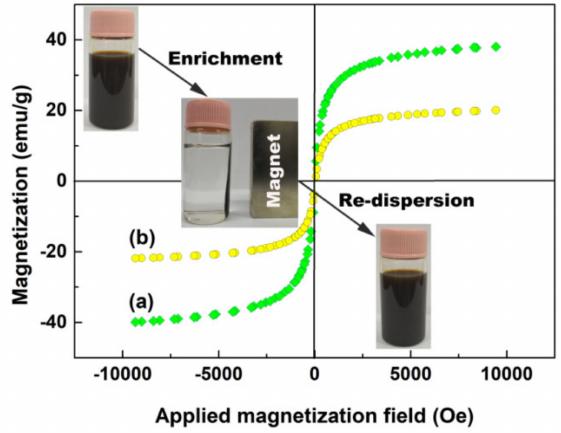
Figure 6. Magnetization hysteresis loops of Fe 3 O 4 @SiO 2 ( a ) and Fe 3 O 4 @SiO 2 -BPMA ( b ) powders (insets are the Fe 3 O 4 @SiO 2 -BPMA suspension, [Fe 3 O 4 @SiO 2 -BPMA] = 1.25 g / L, V = 8.0 mL, aqueous